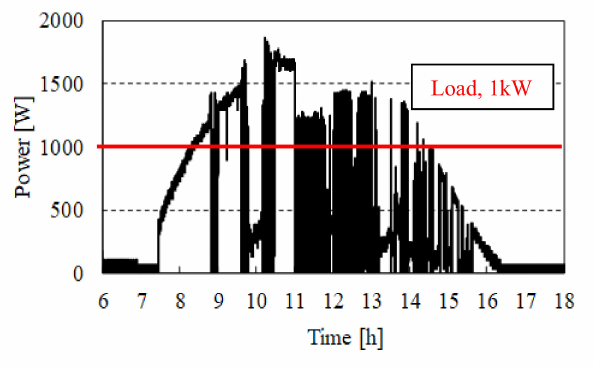
Figure 12. Generated power by a solar panel array in February